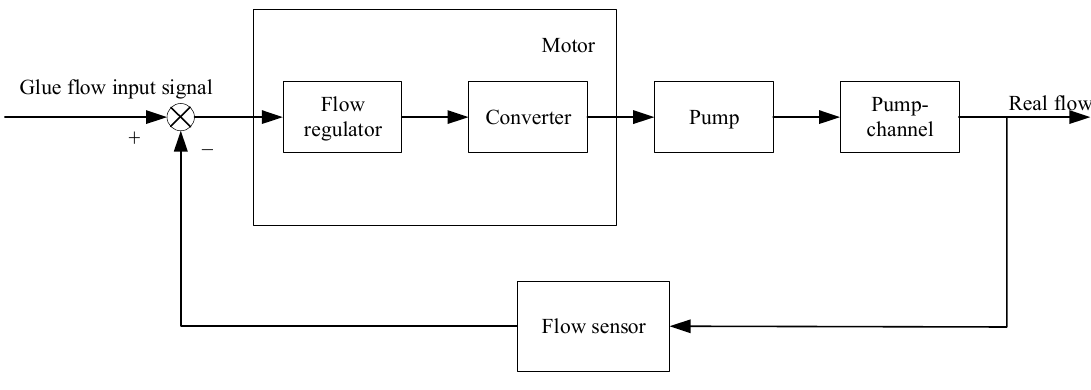
Figure 2. The basic structure of flow control system.